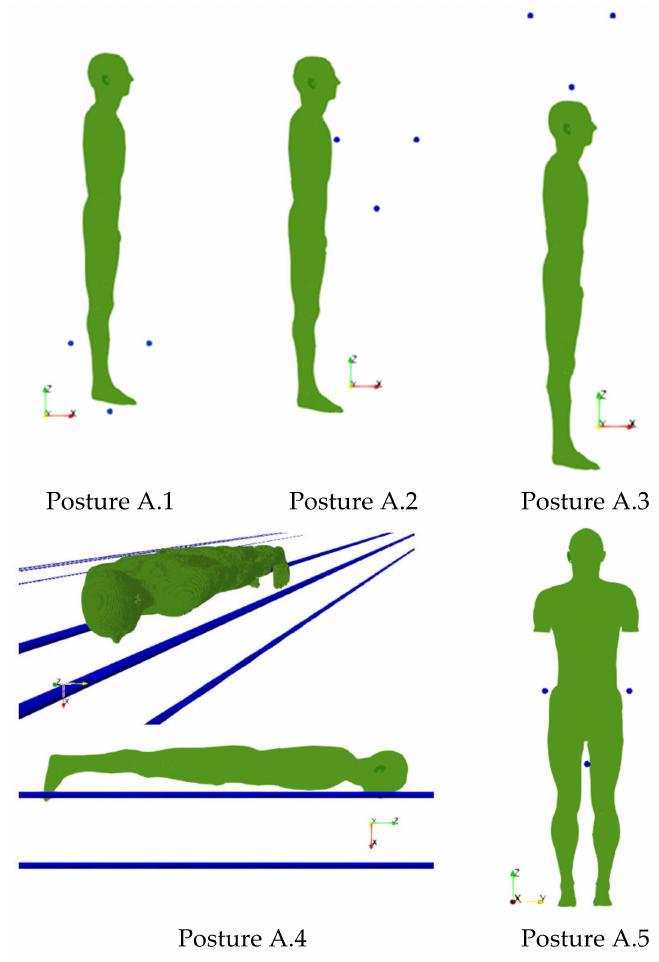
Figure 1. Five considered positions of the human body with reference to the exposure scenario A. The traces of the conductors are also reported in the